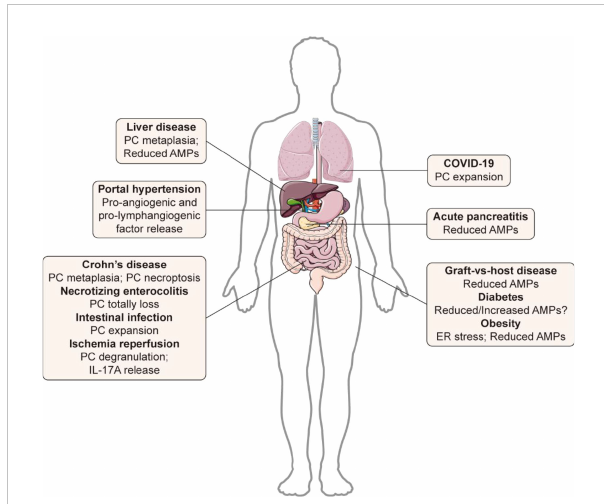
FIGURE 5 Differences in PC performance in various diseases. Paneth cells exhibit different responses to diseases. The most characteristic features of Paneth cells under different pathological conditions are summarized in the fi